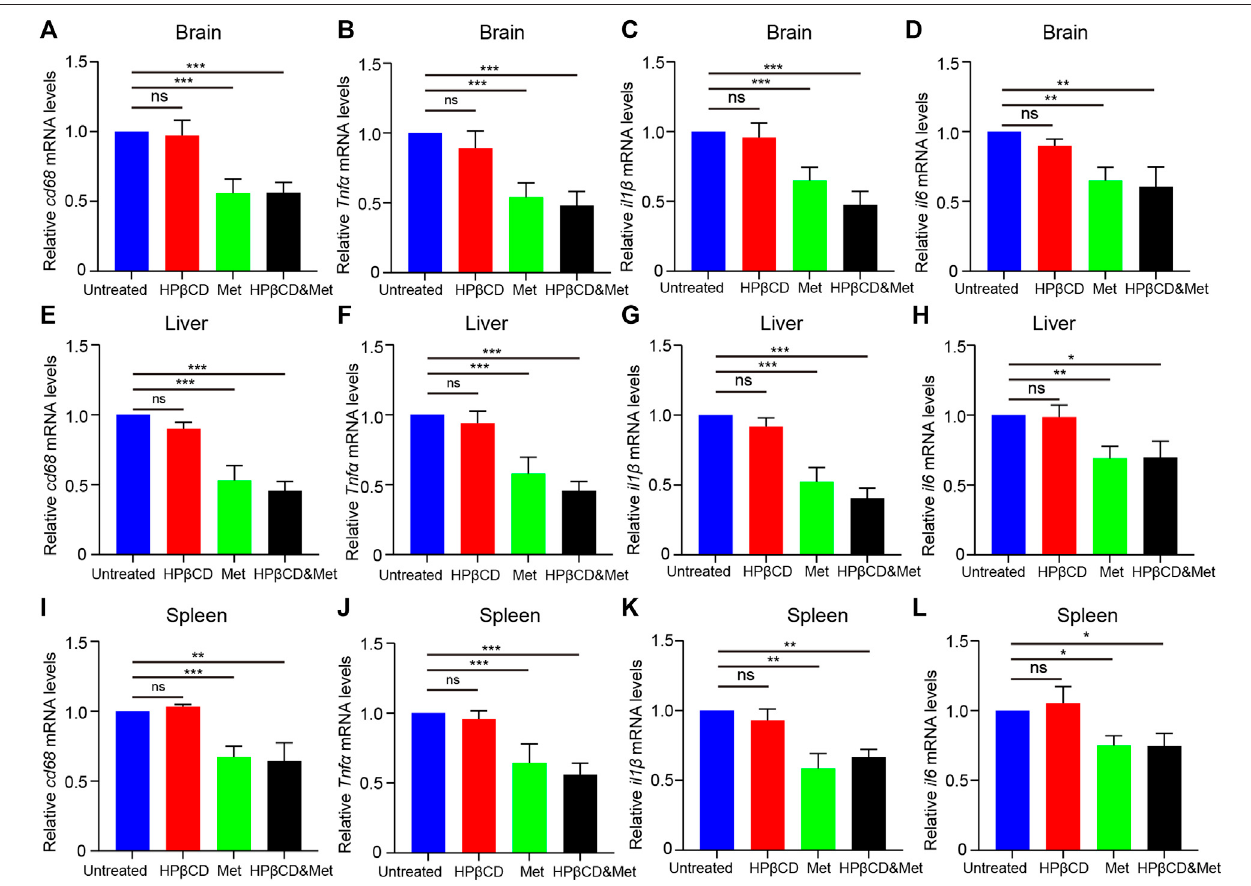
FIGURE 5 | Effects of test drugs on proin fl ammatory cytokine release in Npc1 − / − brain, liver and spleen. Quantitative PCR to study the expression pro fi le of cd68, Tnf α , il1 β and il6 at 8 weeks of age in Npc1 − / − brain (A – D) , liver (E – H) and spleen (I – L) ( n (cid:1) 4). Signi fi cant differences were detected by one-way ANOVA followed by Dunnett ’ s test, ns represents not signi fi cant, * p < 0.05, ** p < 0.01, *** p < 0.001. versus untreated